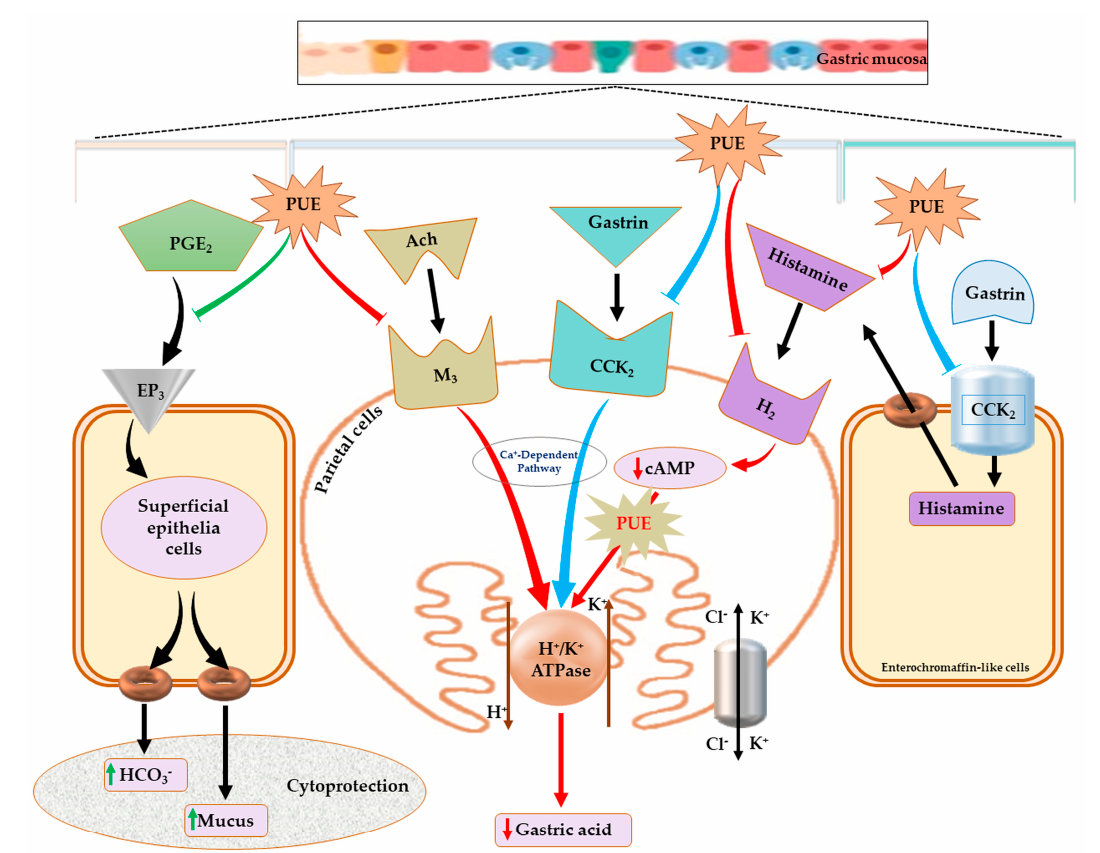
Figure 8. Proposed mechanism for the effects of PUE against gastritis. The schematic pathway illustration indicates that PUE exerts its therapeutic effects against gastritis either by improving cytoprotection through the increased secretion of mucus and bicarbonates following stimulation (green arrow at left side) of PGE 2 production or healing the inflamed gastric mucosa by attenuating gastric acid secretion (red arrows) through downregulation (red arrows) of H + /K + ATPase, H 2 - and M 3 -receptors, and a reduction in cAMP levels. The effects of PUE on the CCK 2 receptor are not significant (blue arrows), but PUE can possibly decrease histamine concentration by an unknown